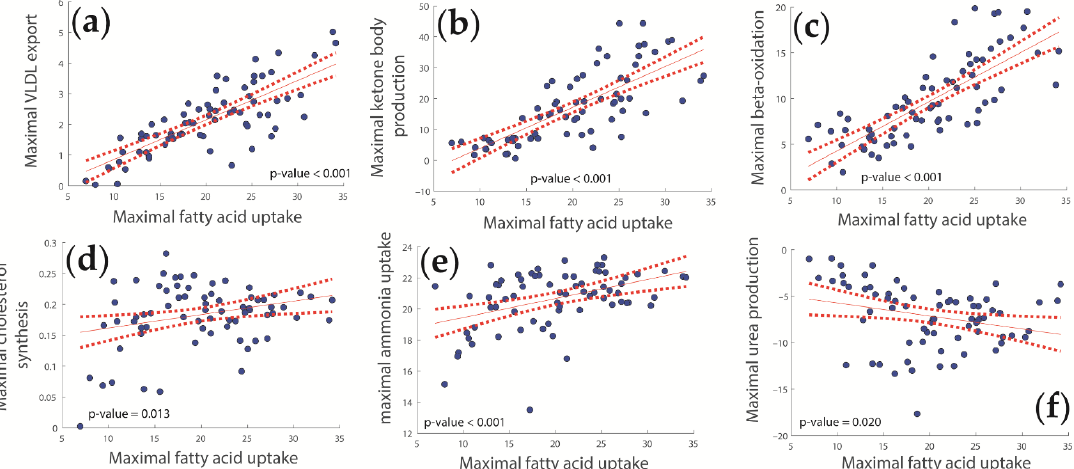
Figure 4. Significant associations between fatty acid uptake and other metabolic functions. ( a ) Lip- oprotein synthesis; ( b ) Ketone Body production; ( c ) β -oxidation; ( d ) Cholesterol synthesis; ( e ) Am- monia uptake; ( f ) Urea production. For full information, see Supplemental Figure S1.